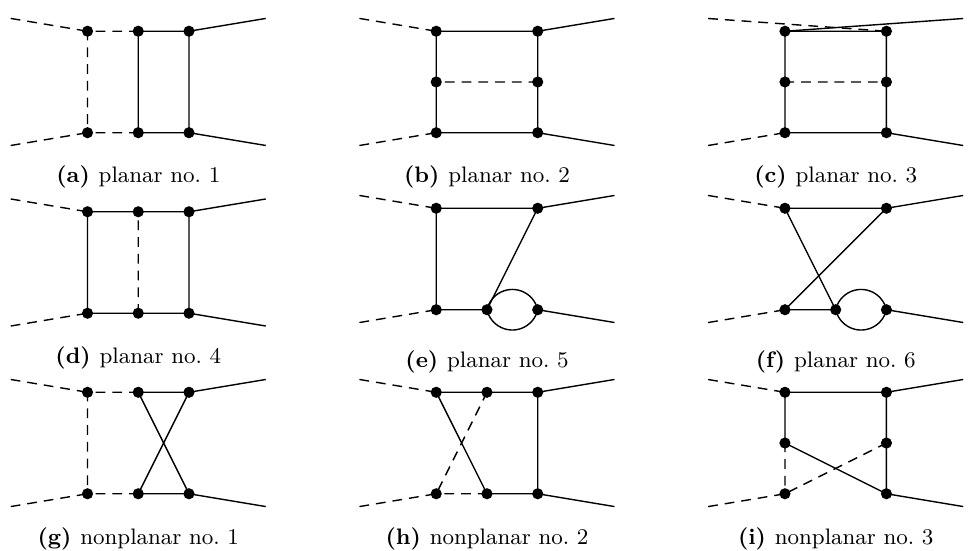
Figure 1. Topologies of integral families. Solid and dashed lines correspond to massive and massless particles respectively. Internal massive particles have mass m t while external massive particles have mass m Z . The first 5 planar topologies and nonplanar no. 3 can be crossed ( p 1 ↔ p 2 ) giving a total of 15